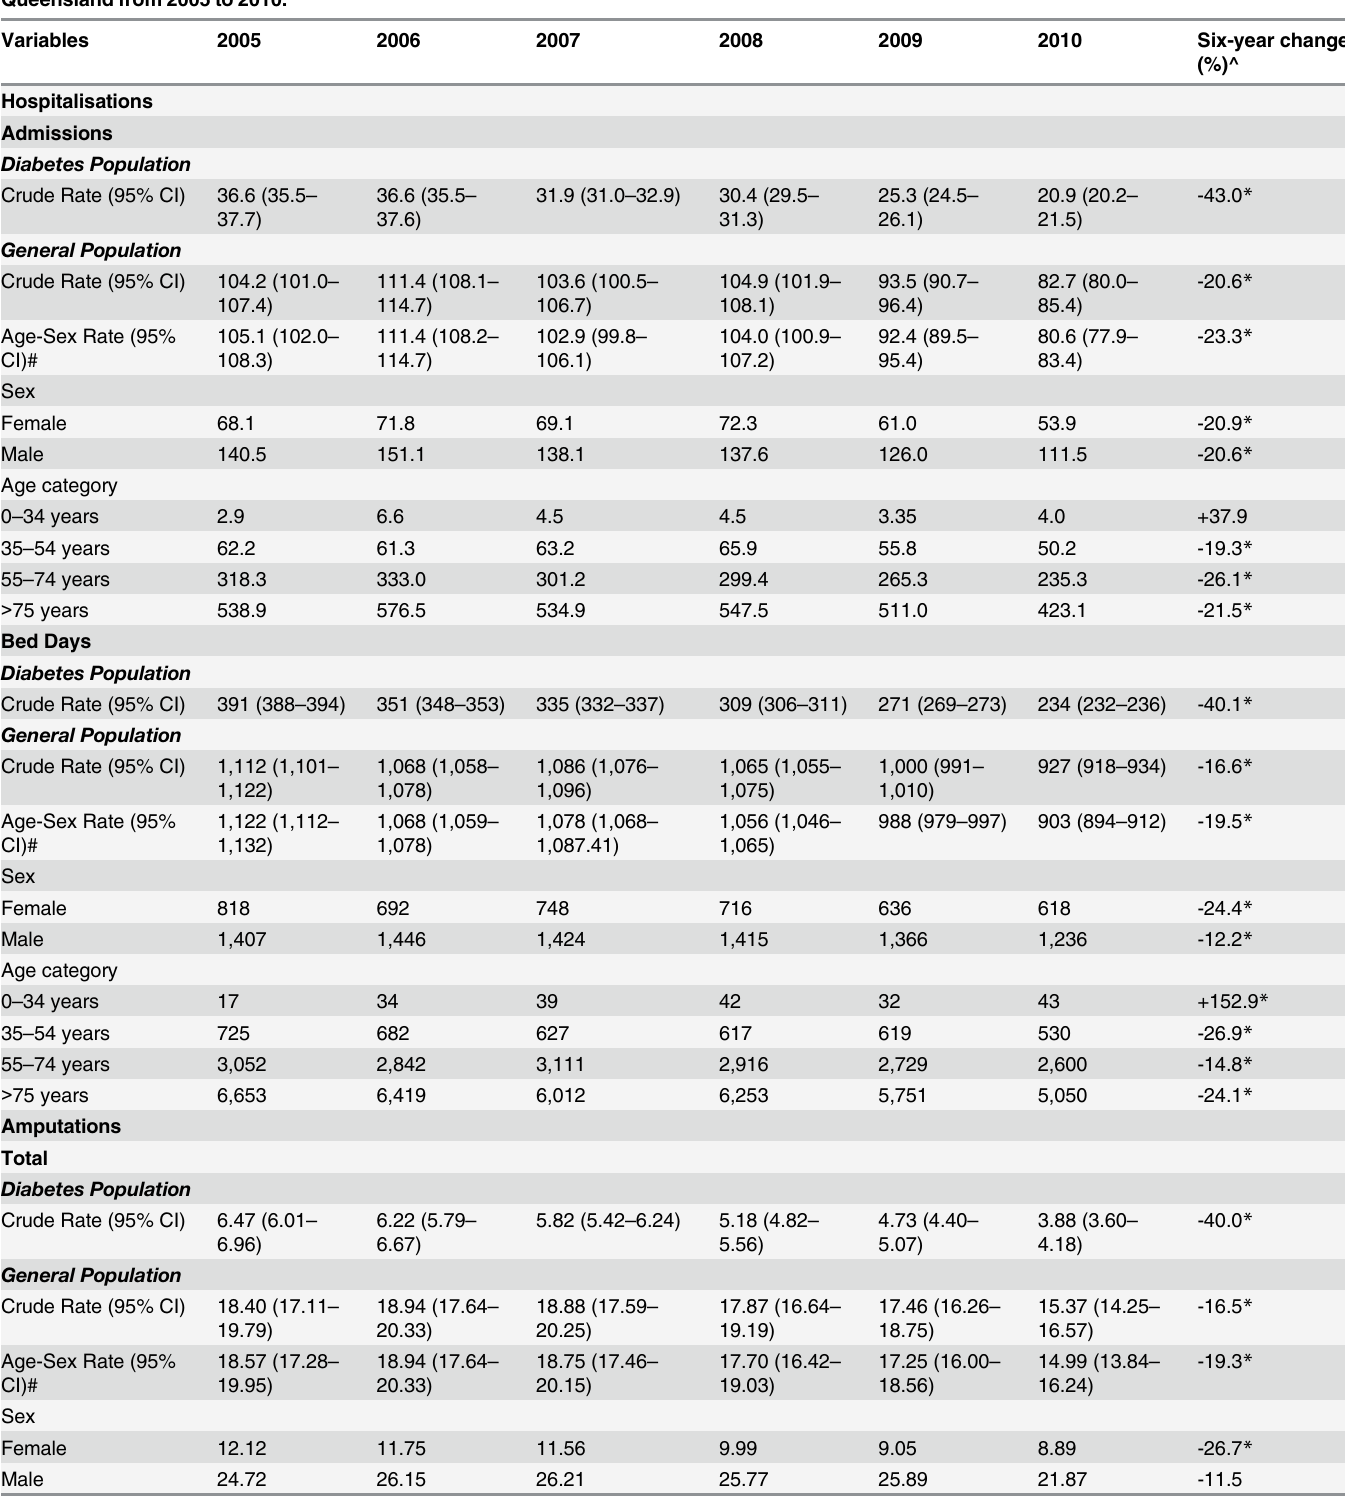
Table 3. Incidence rates of foot-related hospitalisation (admissions and bed days) and amputation (total, minor and major) cases amongst per- sons with diabetes in the estimated diabetes population (per 1,000 person-years) and general resident population (per 100,000 person-years) in Queensland from 2005 to